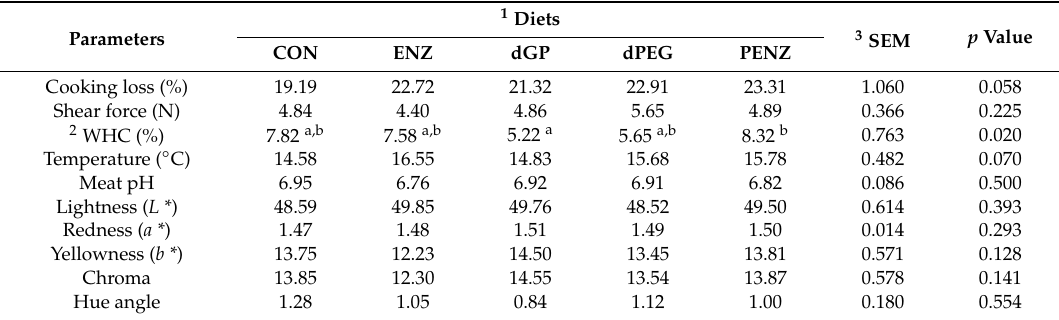
Table 7. E ff ect of grape pomace-containing diets treated with polyethylene glycol and a cellulolytic enzyme mixture on meat quality parameters of broiler